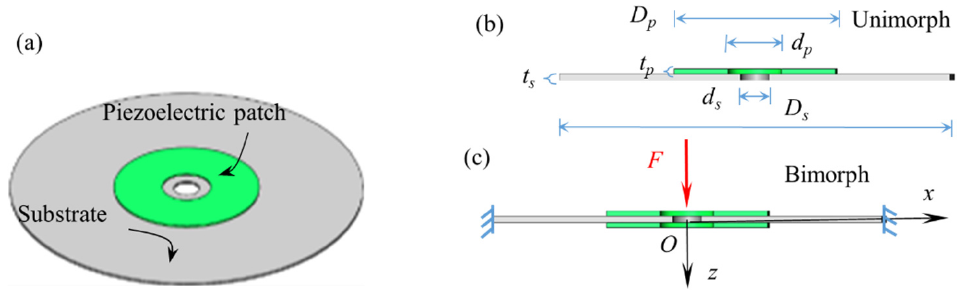
Figure 1. Set-up of a piezoelectric coupled disc (PCD). ( a ) 3D view of PCD; ( b ) normal section view of unimorph PCD; ( c ) normal section view of bimorph PCD.